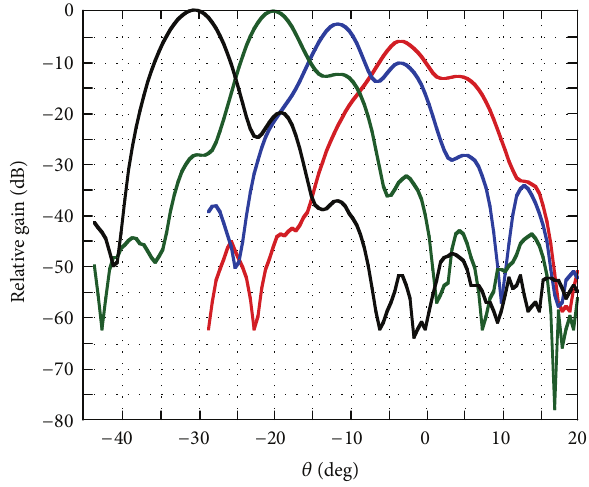
Figure 17: Far-field pattern of detector 330